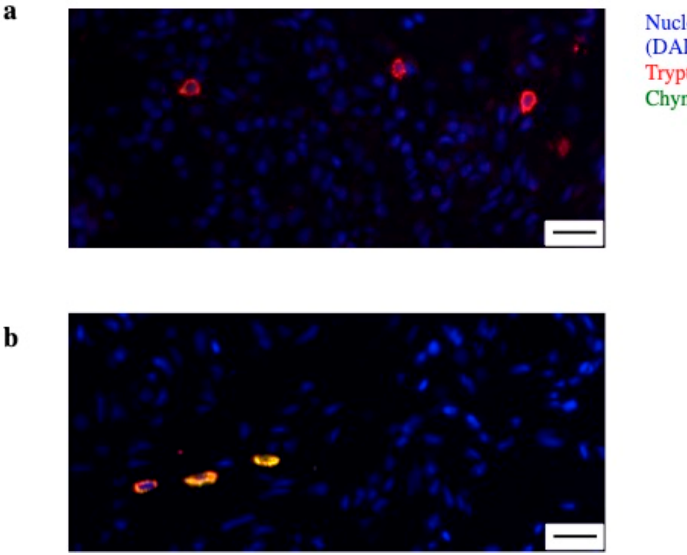
Figure 1. Mast cell (MC) heterogeneity in synovia. ( a ) Immunofluorescence of synovia from an early rheumatoid arthritis (RA) patient showing MC with single positivity for tryptase (red)—MC_T; ( b ) MC double positive for tryptase (red) and chymase (green)—MC_TC. Nuclei in blue (DAPI). Line at 20 µm.